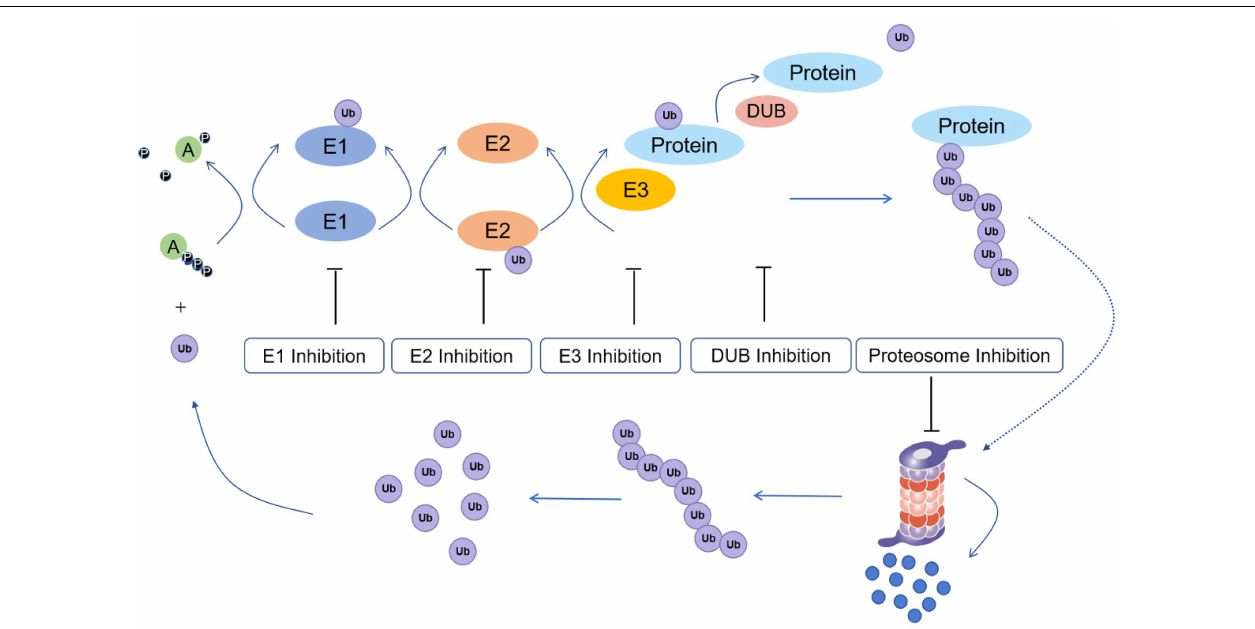
FIGURE 1 | Ubiquitination process and potential drug inhibition targets (E1: ubiquitin-activating enzyme; E2: ubiquitin conjugating enzyme; E3: ubiquitin protein ligase; Protein: substrate/target protein; DUB: deubiquitinating